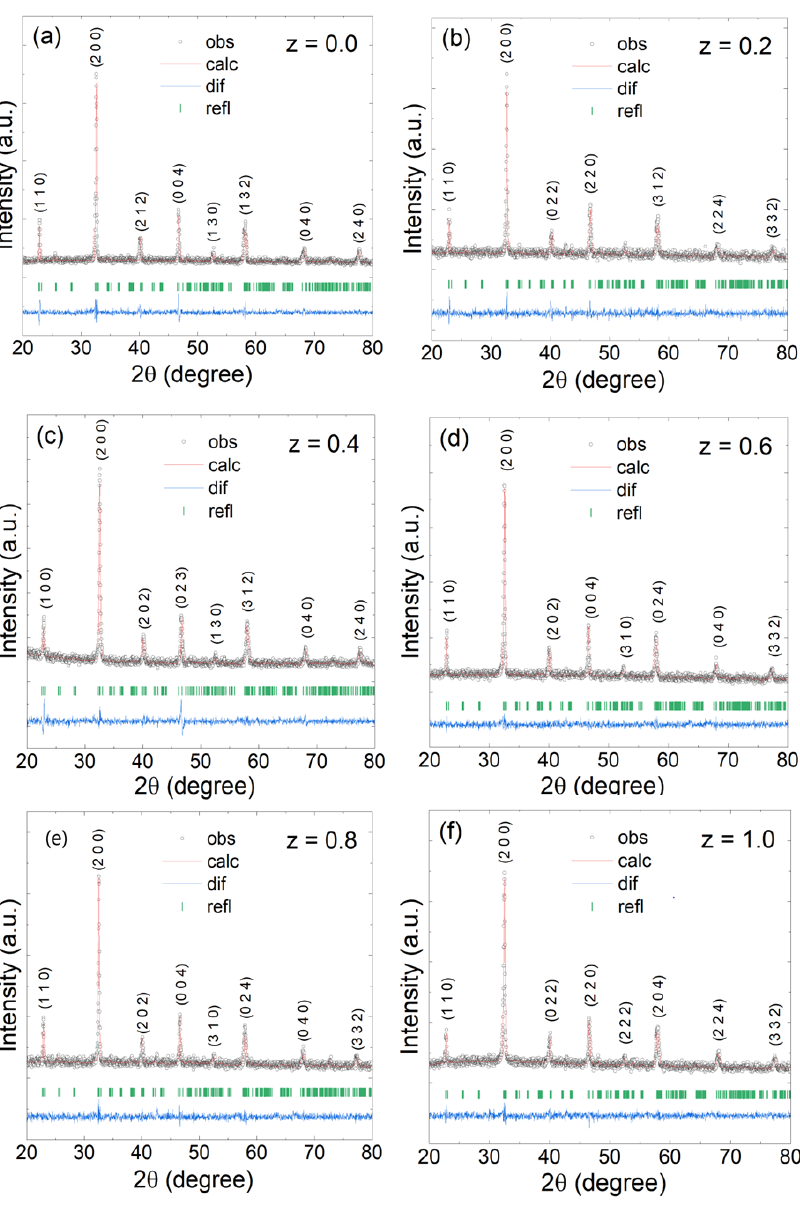
Figure 1. The X-ray diffraction scans of ( a ) La 2 CoMnO 6 ( b ) La 2 Co 0.8 Fe 0.2 MnO 6 ( c ) La 2 Co 0.6 Fe 0.4 MnO 6 ( d ) La 2 Co 0.4 Fe 0.6 MnO 6 ( e ) La 2 Co 0.2 Fe 0.8 MnO 6 ( f ) La 2 FeMnO 6 . The Braggs peaks were slightly shifted towards the right with more iron substitution because the ionic radius of the Fe +3 (0.645 Å) ion is relatively larger than the Co +3 (0.61 Å) ion. The larger ionic radius caused expansion or shrinkage of the structure and a slight increase in the lattice parameters a, b, and c. Due to the variation in particle size, the surface-to-volume ratio also fluctuated. The obtained refined lattice-parameter values are listed in Table 1, which are in agreement with the parameters reported by others